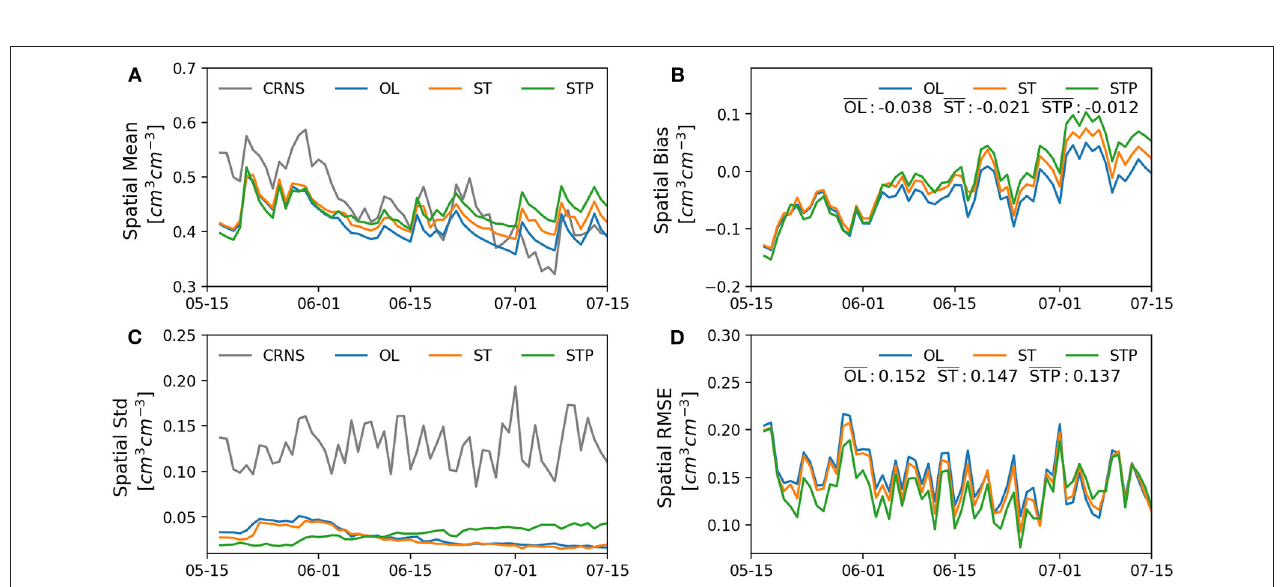
FIGURE 6 | Temporal evolution of (A) spatial mean and (C) spatial standard deviation, respectively, for root zone SWC derived using CRNS and open loop (OL), state estimation (ST) and state–parameter estimation (STP) model runs. Similarly (B,D) represents the spatial Bias and spatial RMSE, respectively, during OL, ST, and STP model runs. The the statistics RMSE and Bias were computed with respect to CRNS derived SWC estimates at the Fendt study site from 15 May 19 to 16 July 19. Both the assimilation runs (ST and STP) soil moisture estimates belongs to the evaluation period (10 May 19–30 Aug 19).